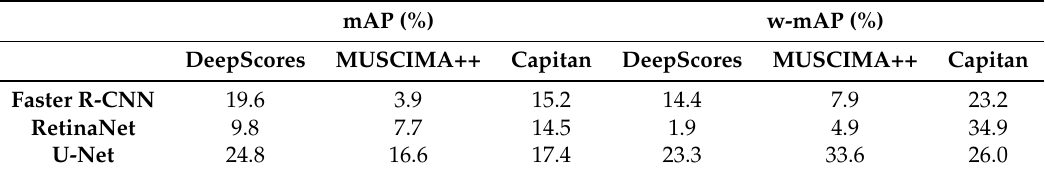
Table 2. Results in terms of mAP (%) and w-mAP (%) with respect to the dataset and object detector model following the COCO evaluation